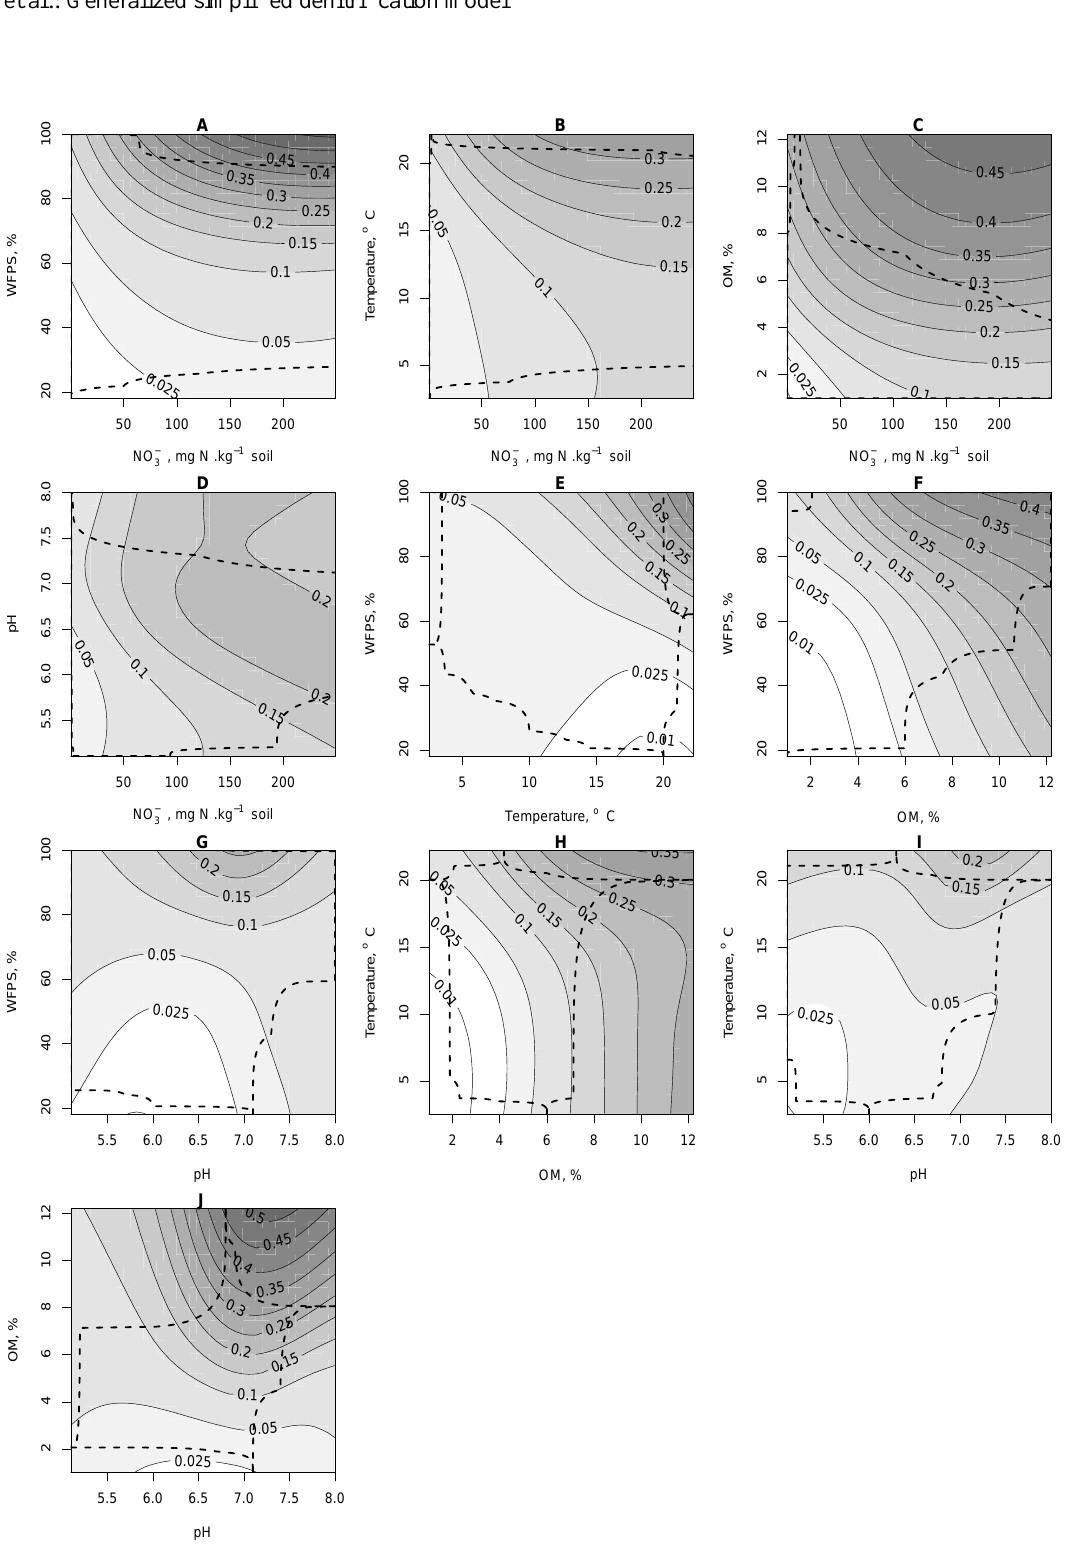
Fig. 9. Mean bivariate partial dependence of ANN5(OM,pH)G models, in mgNkg − 1 soild − 1 . Dashed lines delineate the presence of data points, using a generalisation of the convex hull (Gagolewski,